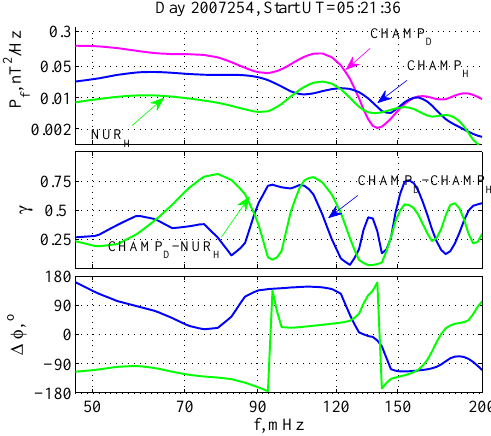
Figure 3. PSD spectra, spectral coherence, γ , and phase difference, (cid:49)ϕ , for the interval shown in Fig. 2.